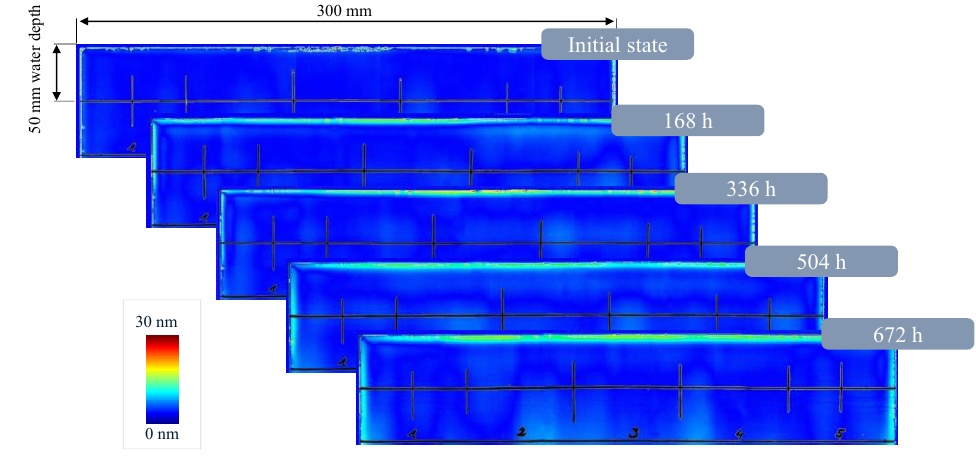
Fig. 4 Change of photoelastic measurements as a result of penetrating moisture influencing the plastic interlayers within laminated glass; Significant increase of photoelastic influence at the edge region over